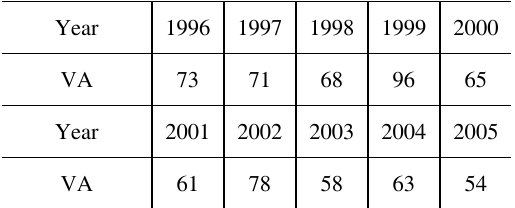
Table 1. Average annual values of VA of radionuclide 137 Cs (Bq/m 3 ) in coastal waters of the Baltic Sea (near Juodkrant ė )